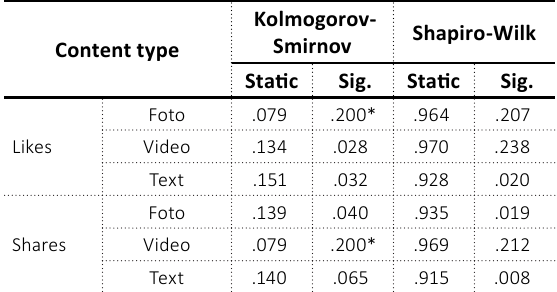
Table 2. Normality test